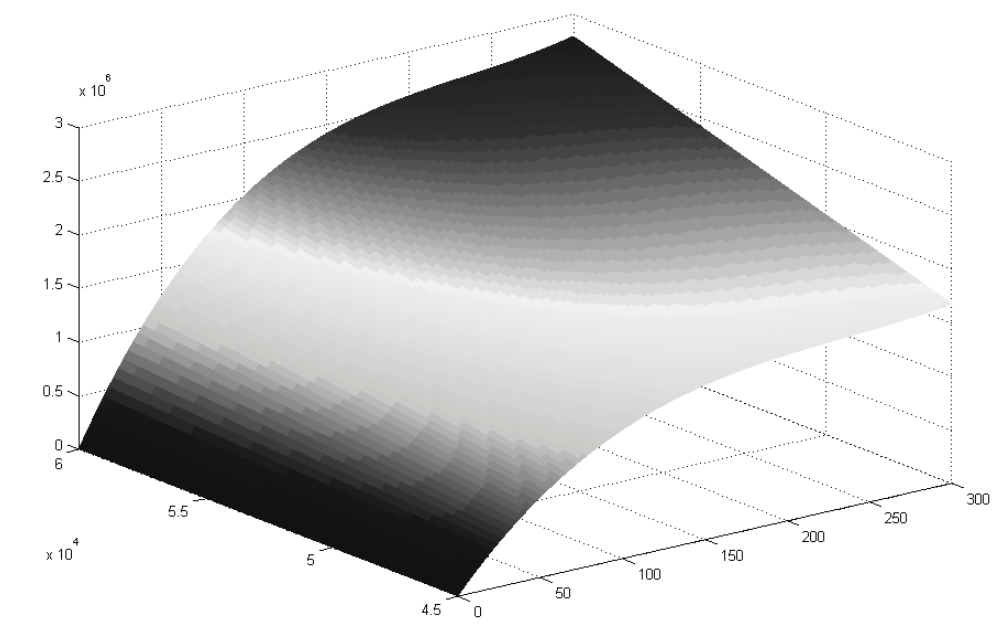
figure 11. The camber of total